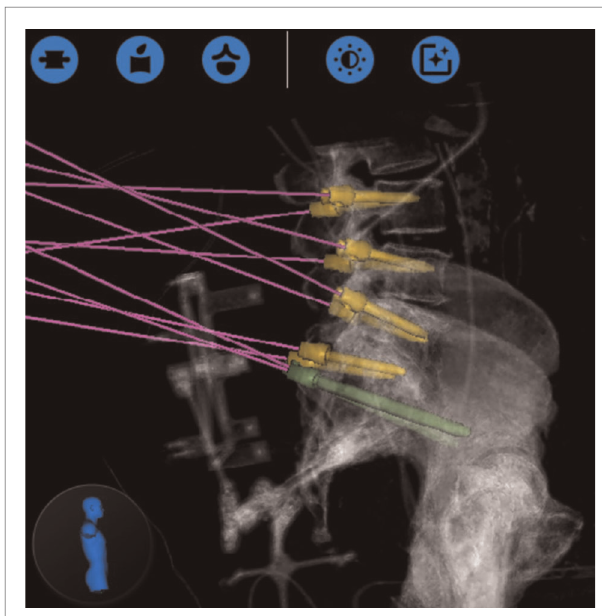
FIGURE 2 | Globus ExcelsiusGPS® preoperative planning phase showing the placement of the iliac screws prior to their insertion (from (22), used with